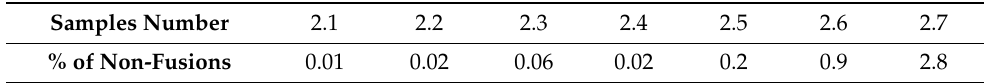
Table 3. Percentage of the non-fusion in the second series of experiments. Samples Number